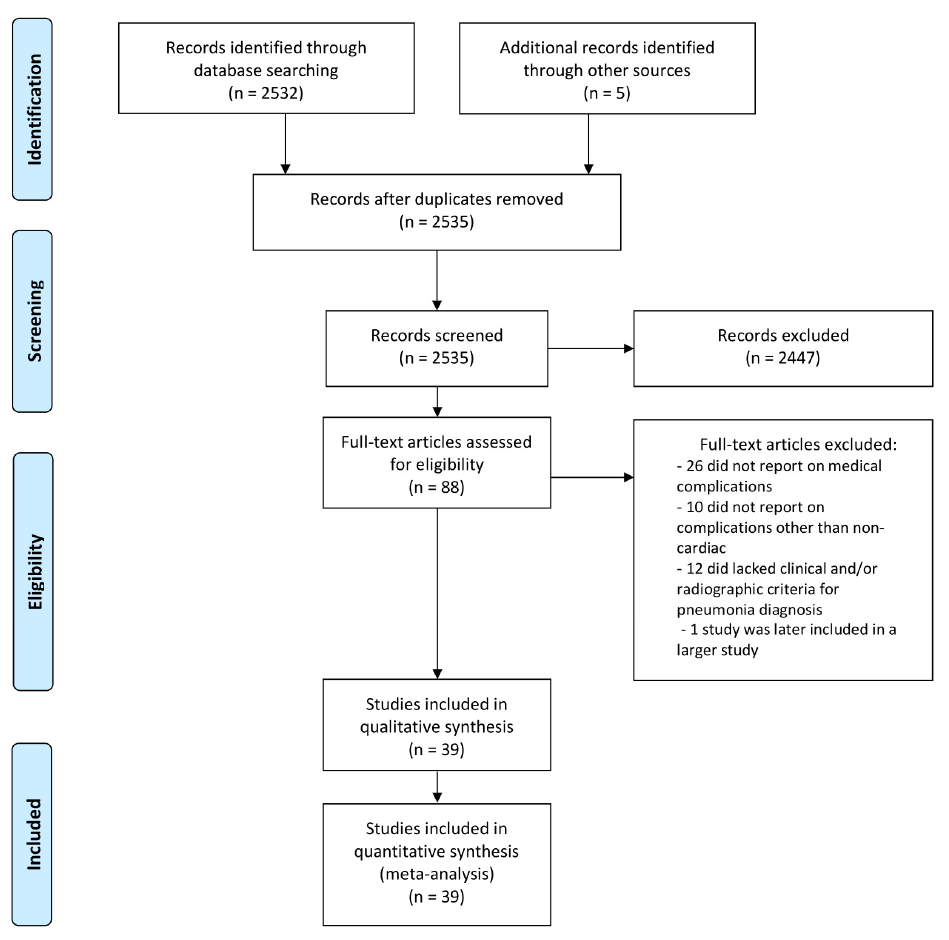
Figure 1. Study flowchart.